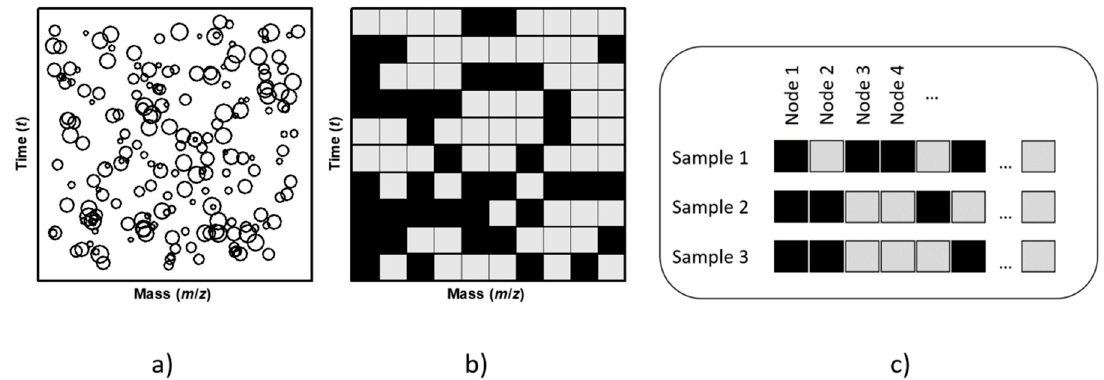
Figure 2. Schematic representation for a sample of the variables and levels grid definition needed to apply the superposing significant interaction rules (SSIR) method: ( a ) a bubble graph representation of the original peak signals; ( b ) after gridding, each node is ultimately assigned to a binary label: low level (grey) or high level (black); ( c ) representation of the discretized grid variables and the respective low and high level series for three samples. Each sample bears its own distribution of labels (codification) along the grid. See text for more details.